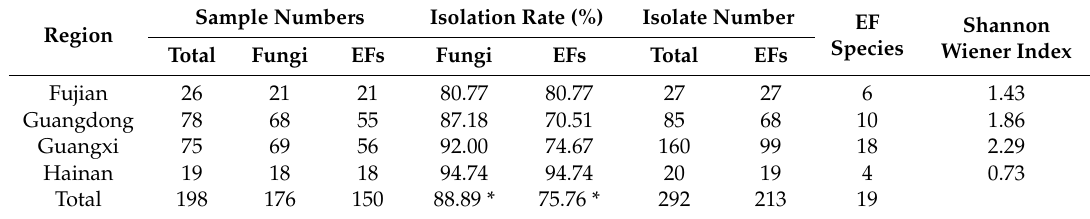
Table 2. The fungi isolation and biodiversity of di ff erent regions.